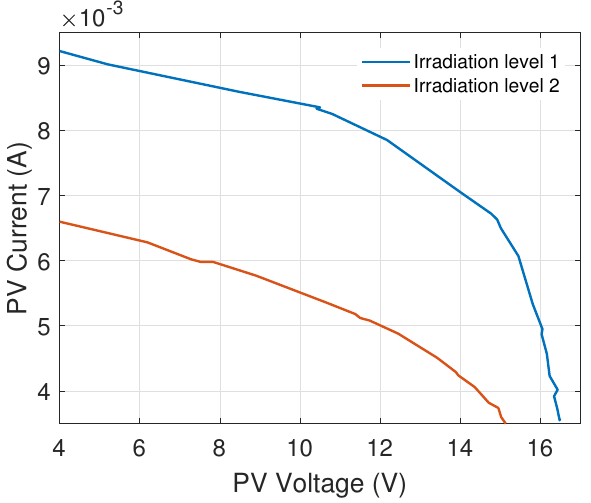
Figure 10. Experimental PV current vs. PV voltage characteristic curve for two irradiation